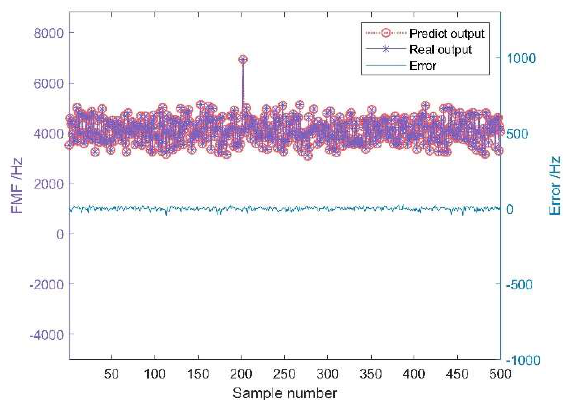
Figure 12. The comparison of the results of the FMF training set.